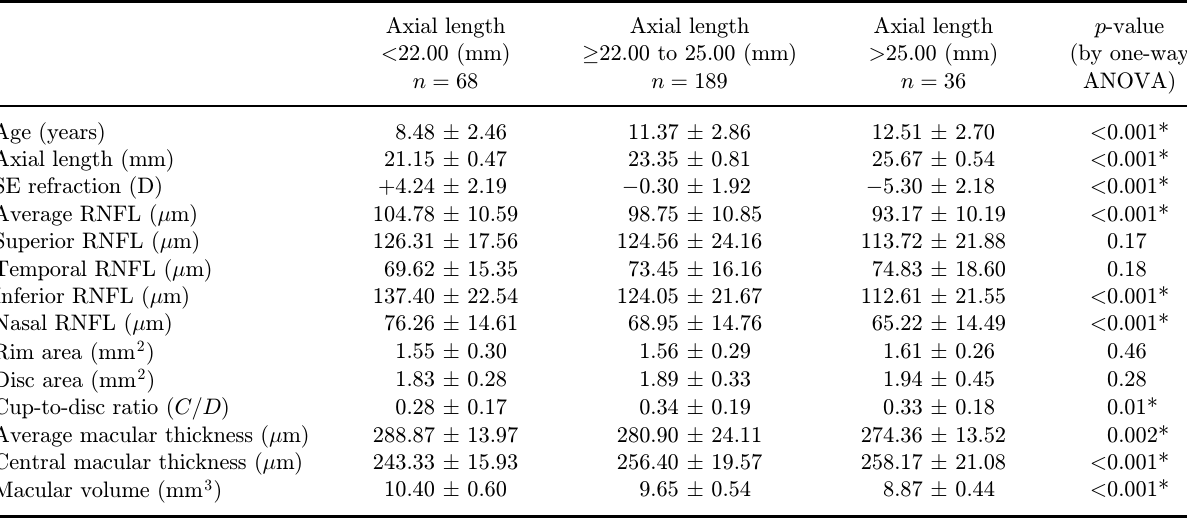
Table 3a. Descriptive and OCT parameters in the three groups examined according to AL: short, medium and long eyes.